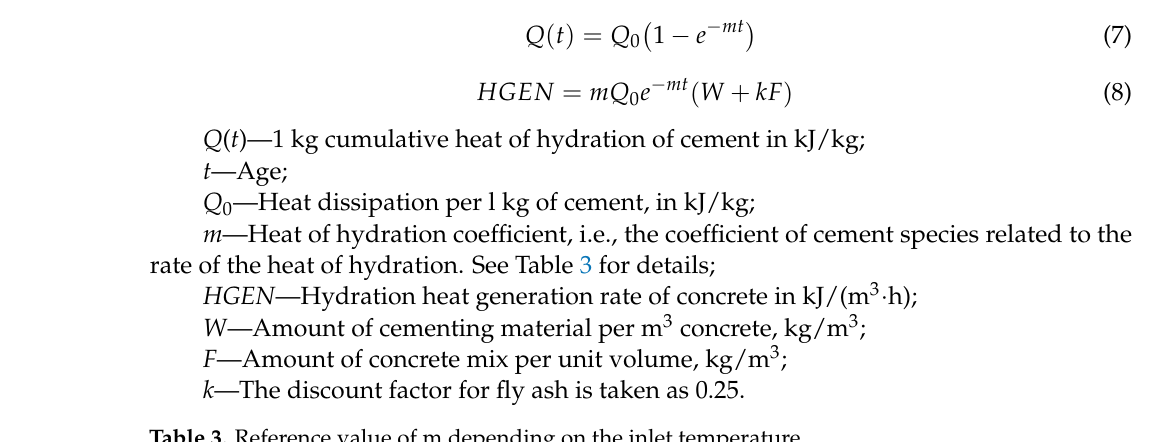
Table 3. Reference value of m depending on the inlet